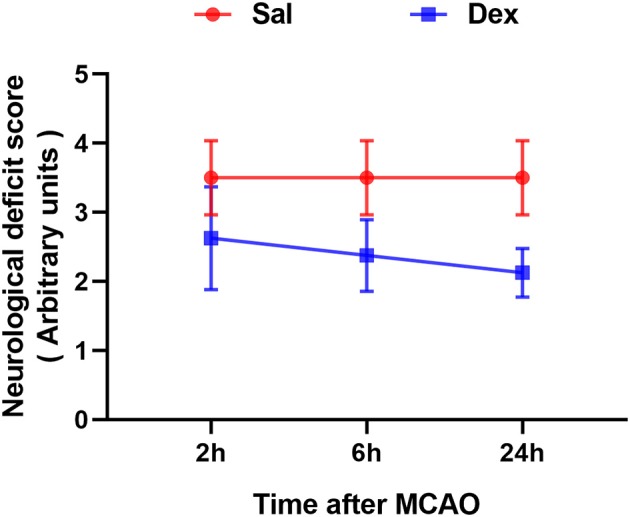
Dexmedetomidine pretreatment reduced the neurological deficit score (NDS) of rats experienced MCAO. Neurological deficit score assessed after MCAO. Dexmedetomidine pretreatment significantly attenuated the NDS after MCAO, but it didn't in a time-dependent manner. Data are expressed as mean ± SD (n sample = 8 animals per group).